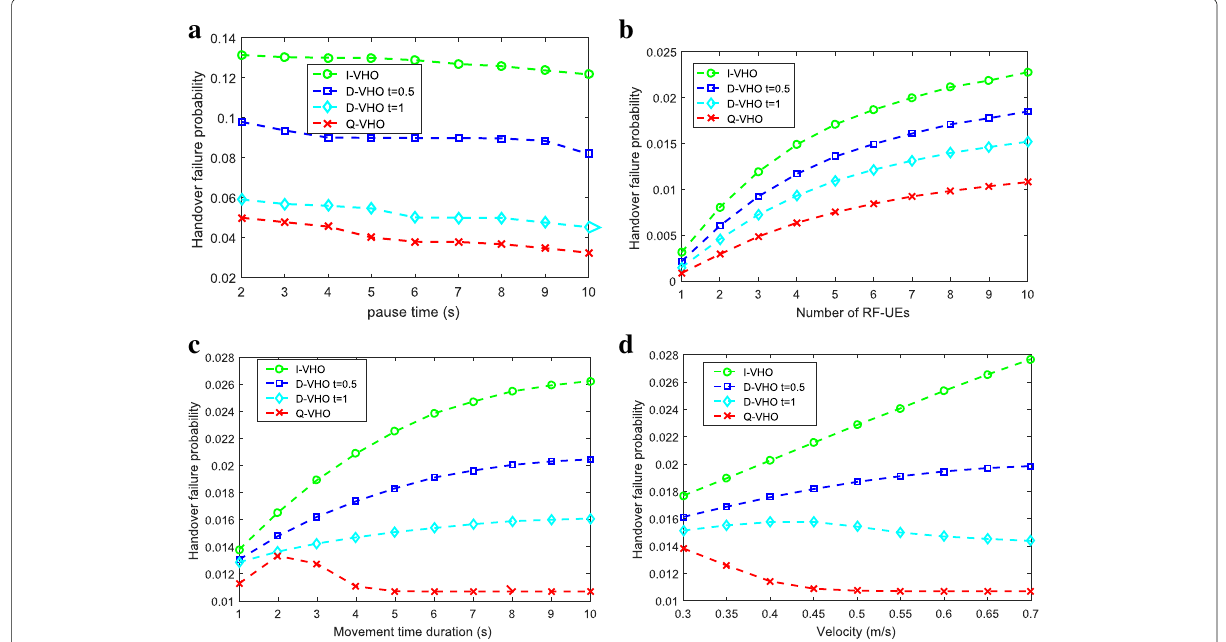
Fig. 4 The impact of the a pause time, b number of RF-UEs, c movement time duration, and d UE velocity on handover failure probability